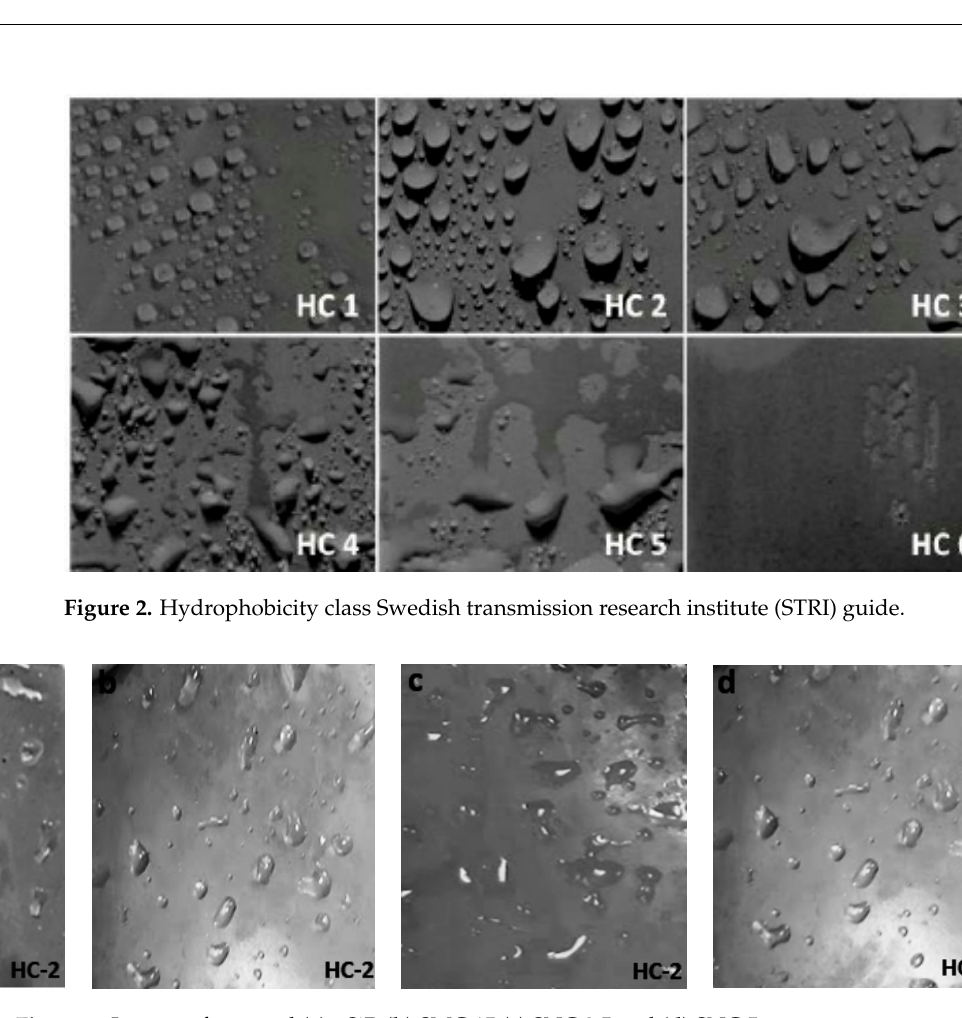
Figure 3. Images of un-aged ( a ) nSiR ( b ) SMC 15 ( c ) SNC 2.5 and ( d ) SNC 5.